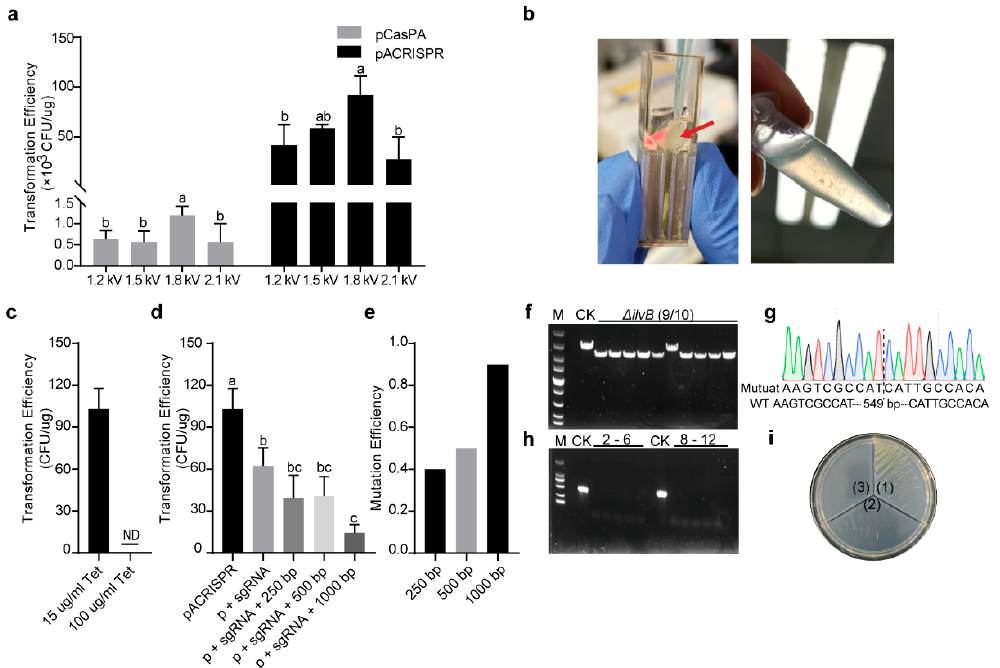
Figure 3. The pCasPA/pACRISPR system–mediated gene editing and plasmid curing after editing in P. fulva . ( a ) Effect of different electroporation pulse strengths for transformation efficiency of the two plasmids. ( b ) P. fulva cells harboring the pCasPA became flocculent by electroporation (left) and bacteria lysed after recovery (right) when incubated in LB with a high concentration (100 µ g/mL) of tetracycline, indicating failure in preparations of P. fulva competent cells for the transformation of the second plasmid pACRISPR. The arrow indicates the floccule after electric pulsing. ( c ) The pACRISPR transformation efficiency of P. fulva cells harboring the pCasPA incubated under different tetracycline concentrations (15 or 100 µ g/mL). ND, not detected (no single colony). ( d ) Transformation efficiency of P. fulva harboring both pCasPA and pACRISPR that assembled with sgRNA and different lengths of homologous repair arms. ( e ) Effect of different lengths of homologous repair arms for gene–editing efficiency. ( f ) Agarose gel electrophoresis and ( g ) Sanger sequencing further verified the edition efficiency of the gene ilvB (9/10). M, DNA marker (from up to down 5000 bp, 3000 bp, 2000 bp, 1500 bp, 1000 bp, 750 bp, 500 bp, 250 bp and 100 bp). ( h ) There were no positive PCR bands when using the specific primers for detecting genome–editing plasmids after plasmid curing. 2–6, PCR amplification using pCasPA–specific primers; 8–12, PCR amplification using pACRISPR–specific primers. M, DNA marker (from up to down 2000 bp, 1000 bp, 750 bp, 500 bp, 250 bp and 100 bp). ( i ) Plate streaking indicated the success of plasmid curing. (1), LB agar without antibiotic; (2) LB agar containing 100 µ g/mL tetracycline; (3) LB agar containing 150 µ g/mL carbenicillin. Statistically significant differences are annotated with different letters ( p <